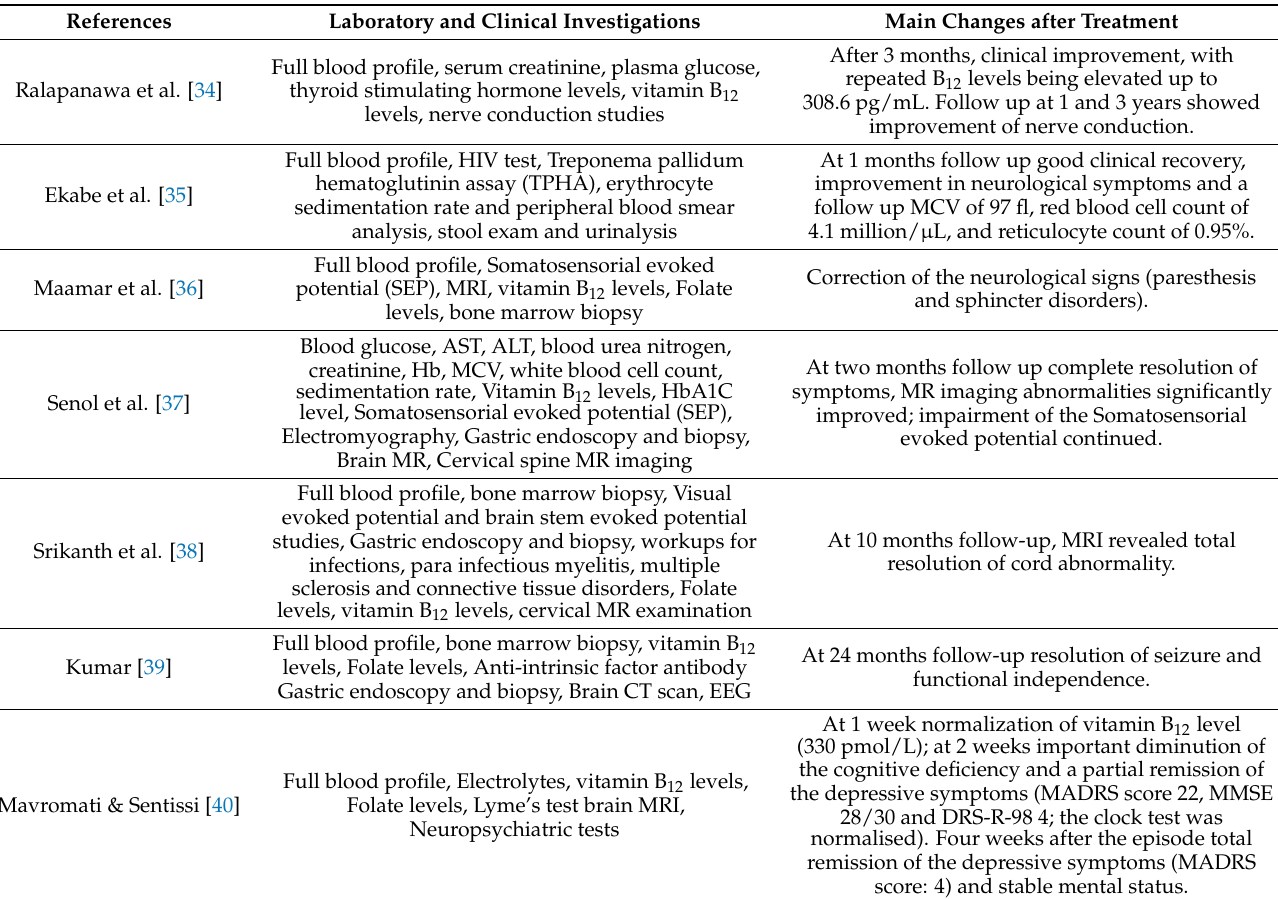
Table 2. Laboratory and clinical investigations of the reported cases in the section on vitamin B 12 and neurological disorders, with main changes after